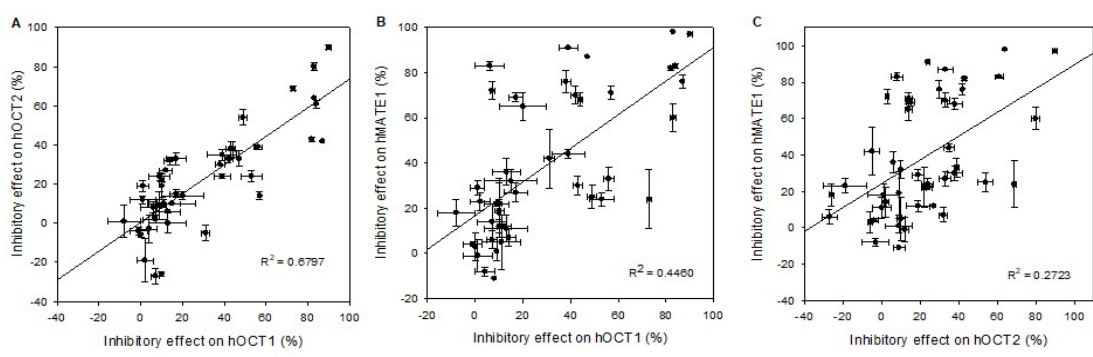
Figure 5. Scatter plot analysis correlating inhibitory effects of ( A ) hOCT1 vs. hOCT2, ( B ) hOCT1 vs. hMATE1, ( C ) and hOCT2 vs. hMATE1. The correlation coefficient R 2 value for the combination hOCT1 vs. hOCT2 is near 0.7, indicating a good correlation between cation transporters, while the combination hOCT1 vs. hMATE1 shows only an R 2 value of 0.45 and for hOCT2 vs. hMATE1 R 2 = 0.27. Data points represent mean and standard deviation of one individual experiment. Mean values are presented in detail in Tables 3 and 4.